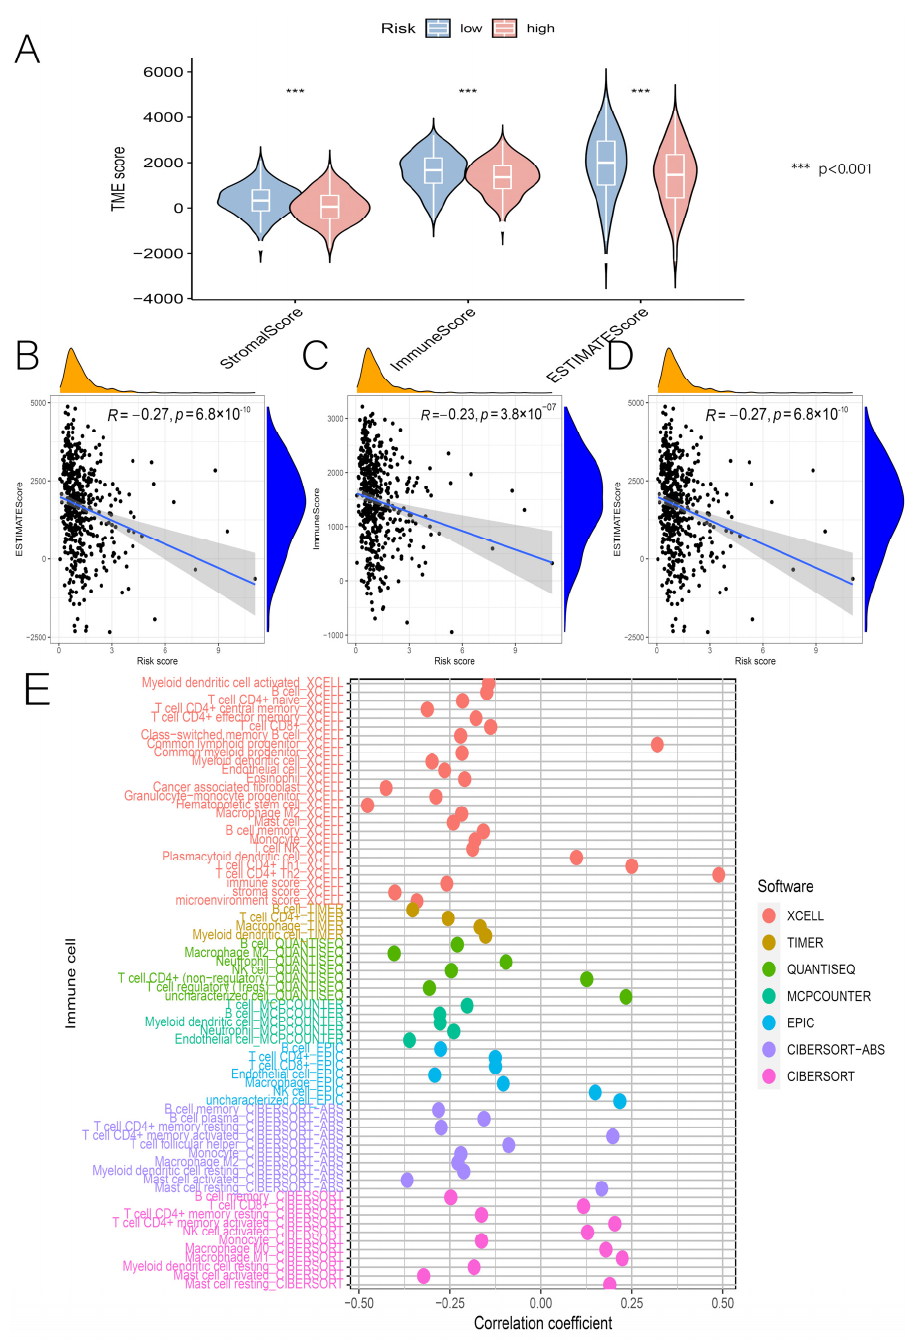
Figure 8. ( A ) Relationship between risk score and tumor microenvironment. ( B – D ) Correlation of StromalScore, ImmuneScore, and ESTIMATEScore with risk score. ( E ) Analysis of risk score correlation with immune cell infiltration based on 7 algorithms. *** p < 0.001.